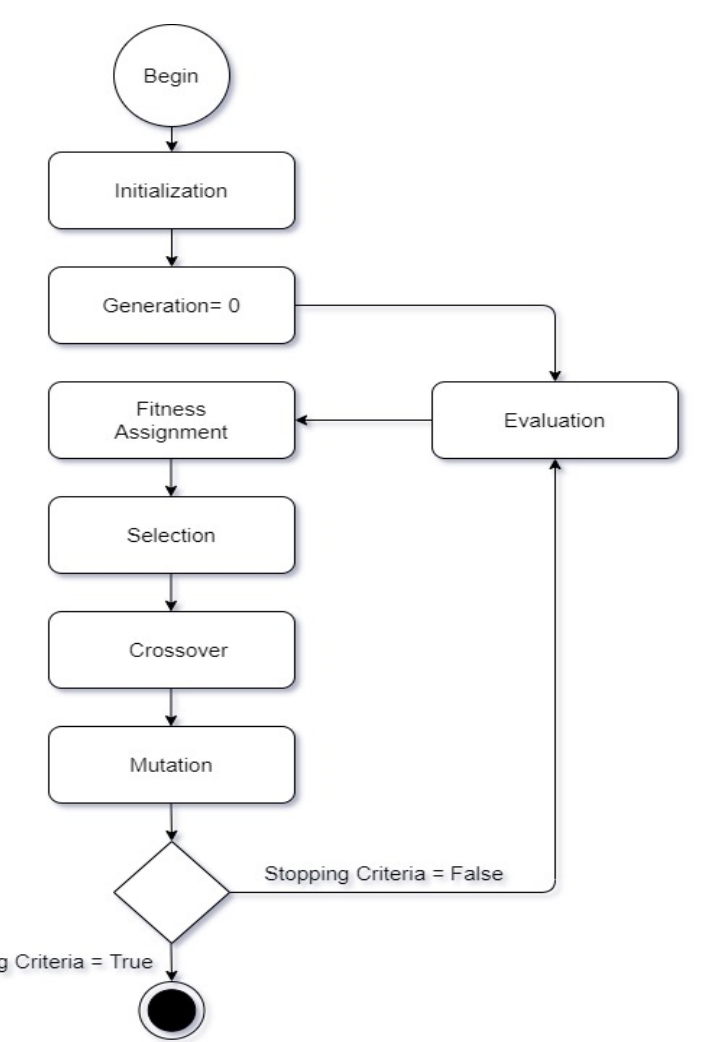
Figure 5. A diagram to show the process of feature selection using a genetic algorithm.